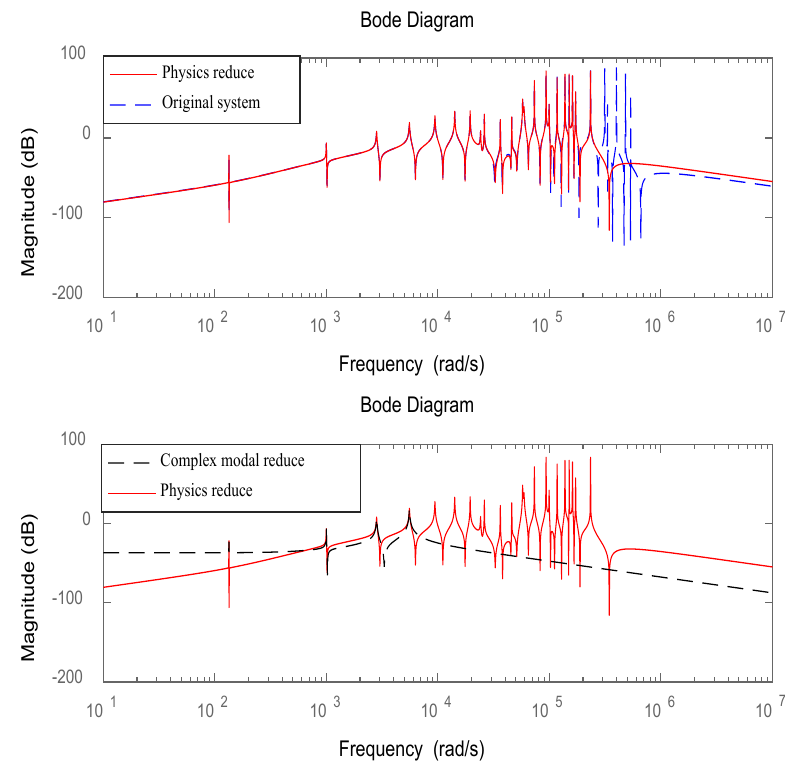
Figure 6. Bode plot for reduced system model of structure 3.